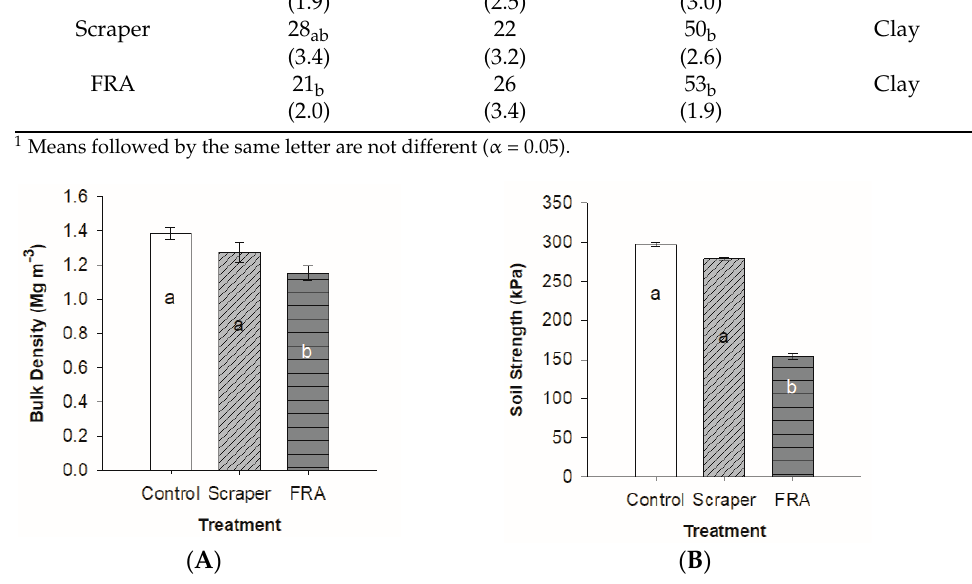
Figure 4. ( A ) Bulk density of each treatment followed by standard error bars. ( B ) Mean soil strength followed by standard error bars. Shared letters are not statistically different ( α = 0.05).